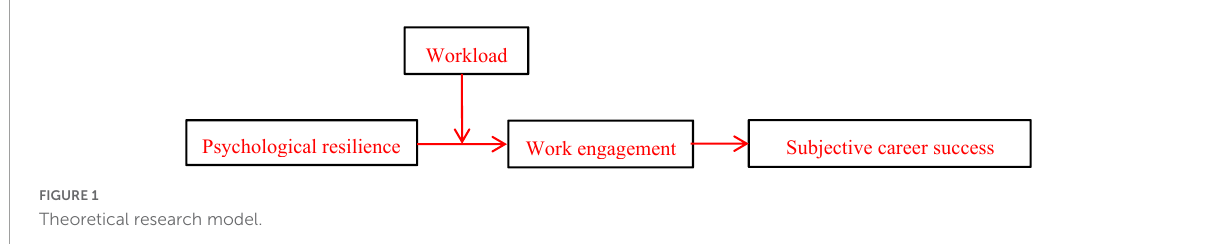
FIGURE1 Theoretical research